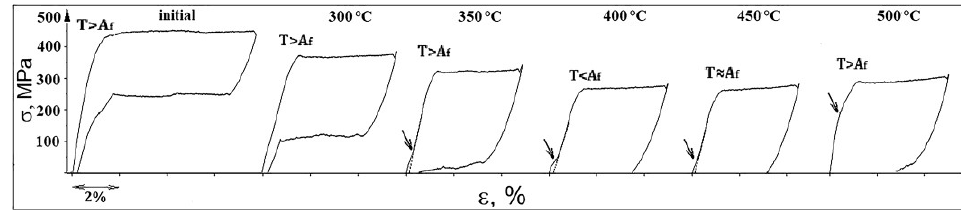
Figure 6. Stress–strain curves in the “loading–unloading” mode obtained during uniaxial tensile tests; arrows indicate deviations from linearity due to stress-induced formation of the R phase.